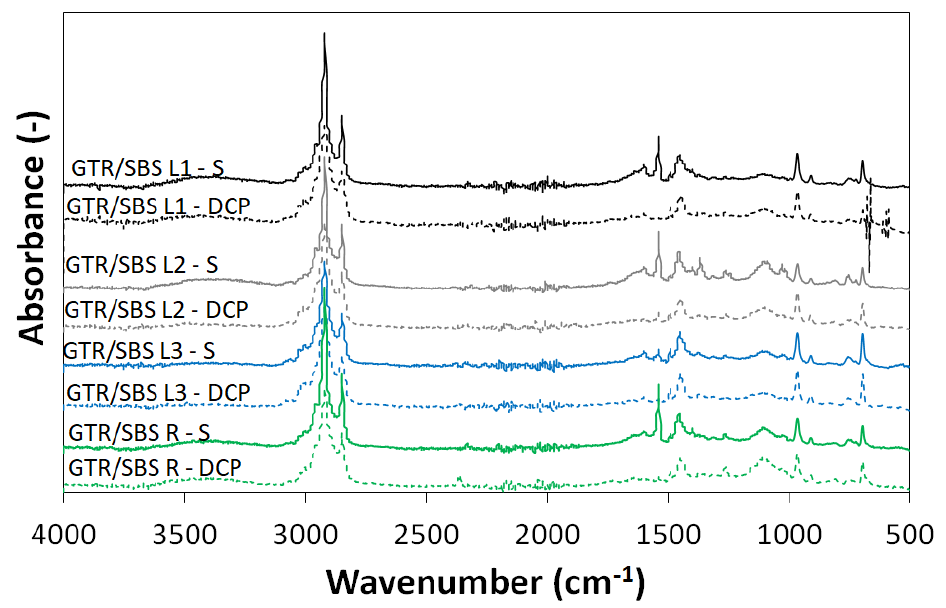
Figure 2. FTIR spectra of GTR/SBS blends as function of SBS grade and curing agent .